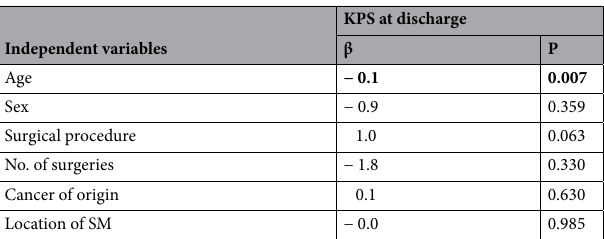
Table 3. Multiple linear regression of KPS at discharge and after 12 months in relation to various independent variables, controlled by preoperative KPS. P level of significance, No. number, SM spinal metastasis. Bold type indicates statistically significant